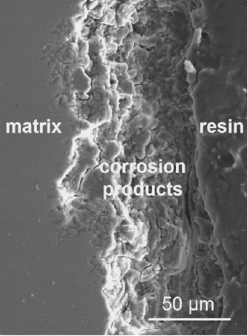
Figure 8. SEM images of the cross-section of AZ31 magnesium alloy specimens exposed for 12 months in dynamic marine environment of ocean voyage.